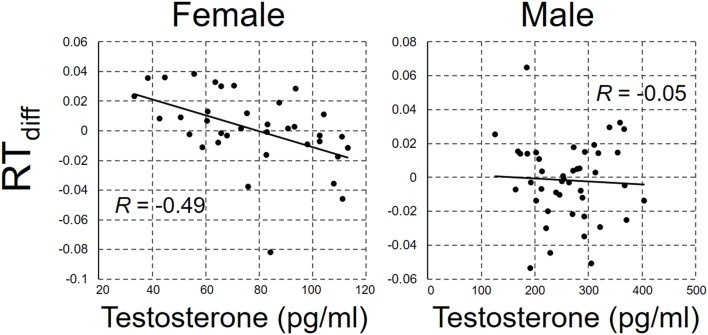
The scatterplot between RTdiff and salivary testosterone concentration for female and male participant.